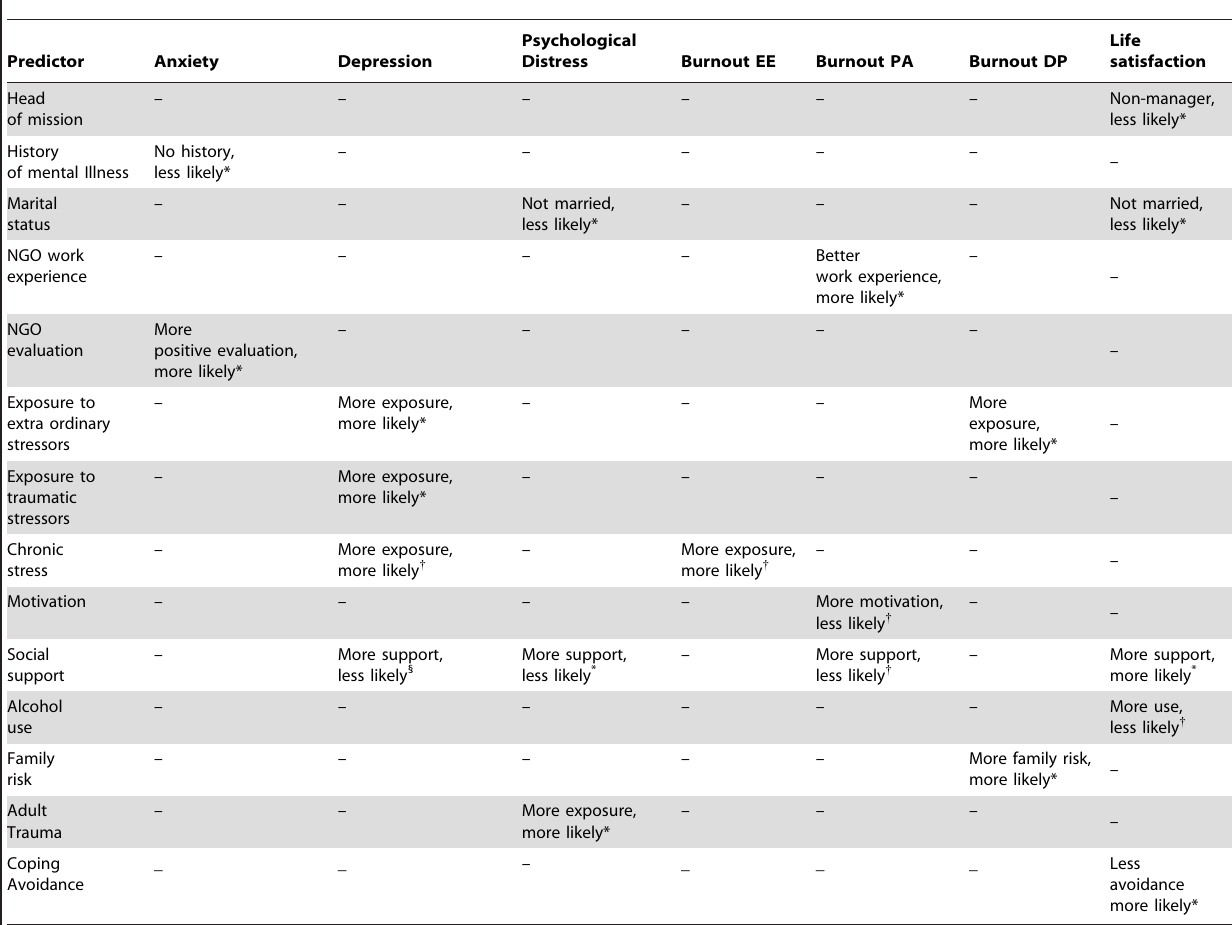
Table 6. Overview of longitudinal GEE models: all outcomes and selected variables with statistically significant associations across